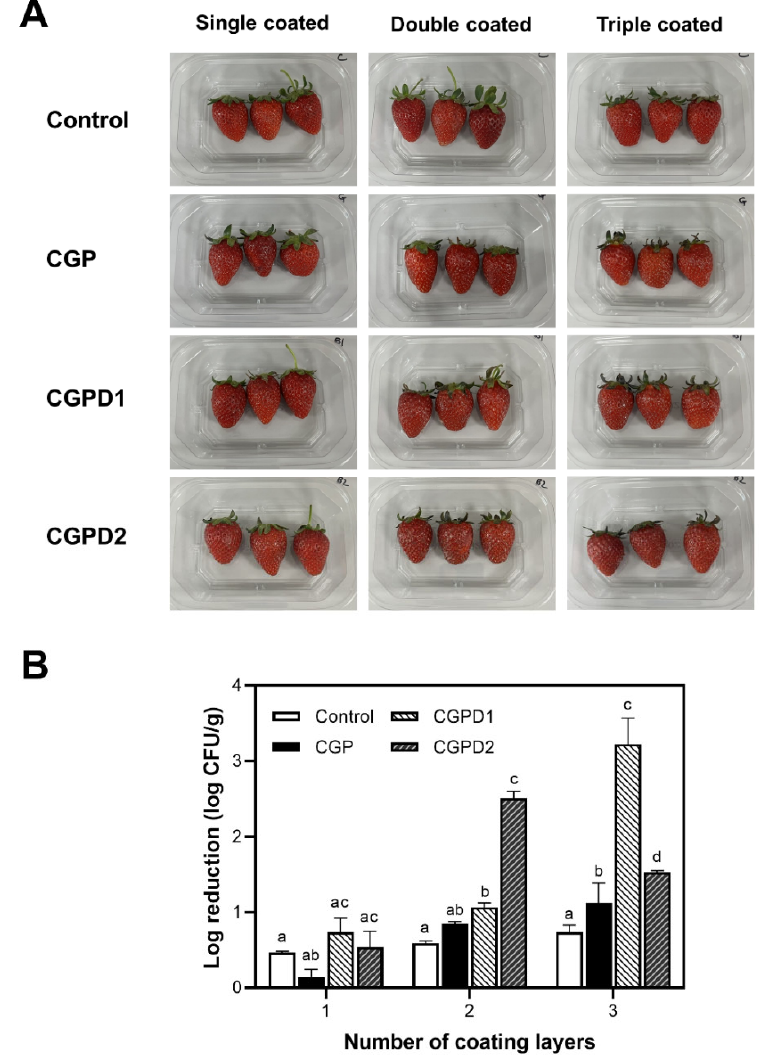
Figure 4. Images ( A ) and antimicrobial properties ( B ) of coated strawberry according to the number of coating layers on the first day of storage. Different small letters indicate significant differences among means in the same column ( p < 0.05).